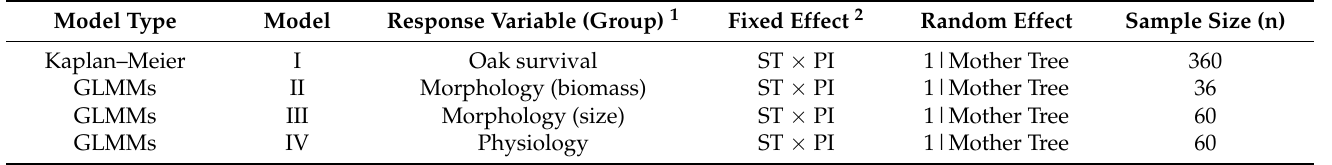
Table 1. Summary of maximal models performed for data analysis in this study.